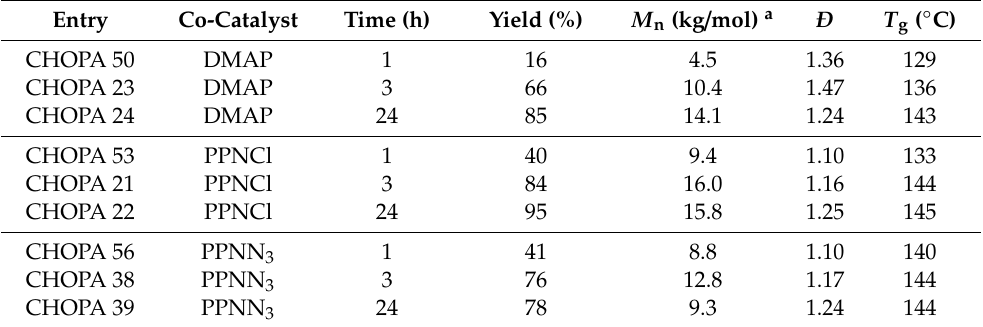
Table 3. CHO / PA copolymerization catalyzed by complex 2 and di ff erent co-catalysts a